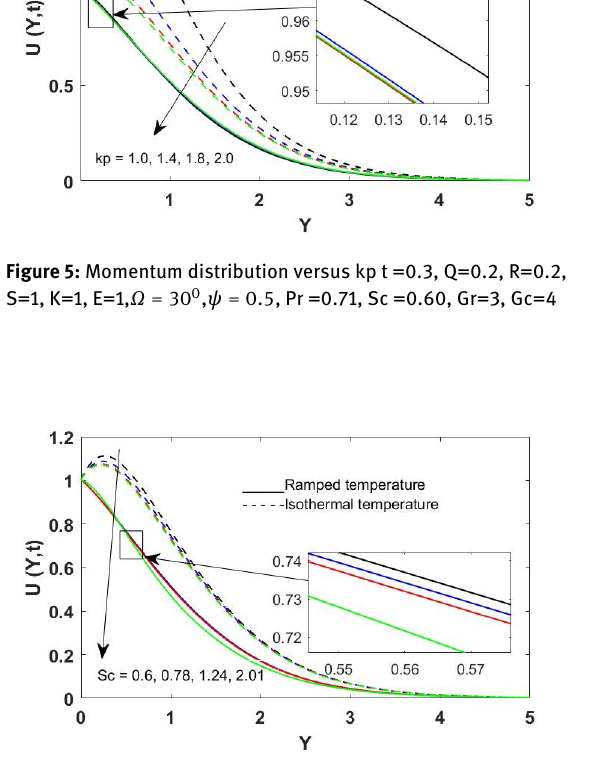
Figure 6: Momentum distribution versus Sc t =0.3, R=0.2, S=1, K=1, kp=1.5, E=1, Q=0.2, Ω = 30 0 , ψ = 0.5 , Pr =0.71, Gr=3, Gc=4